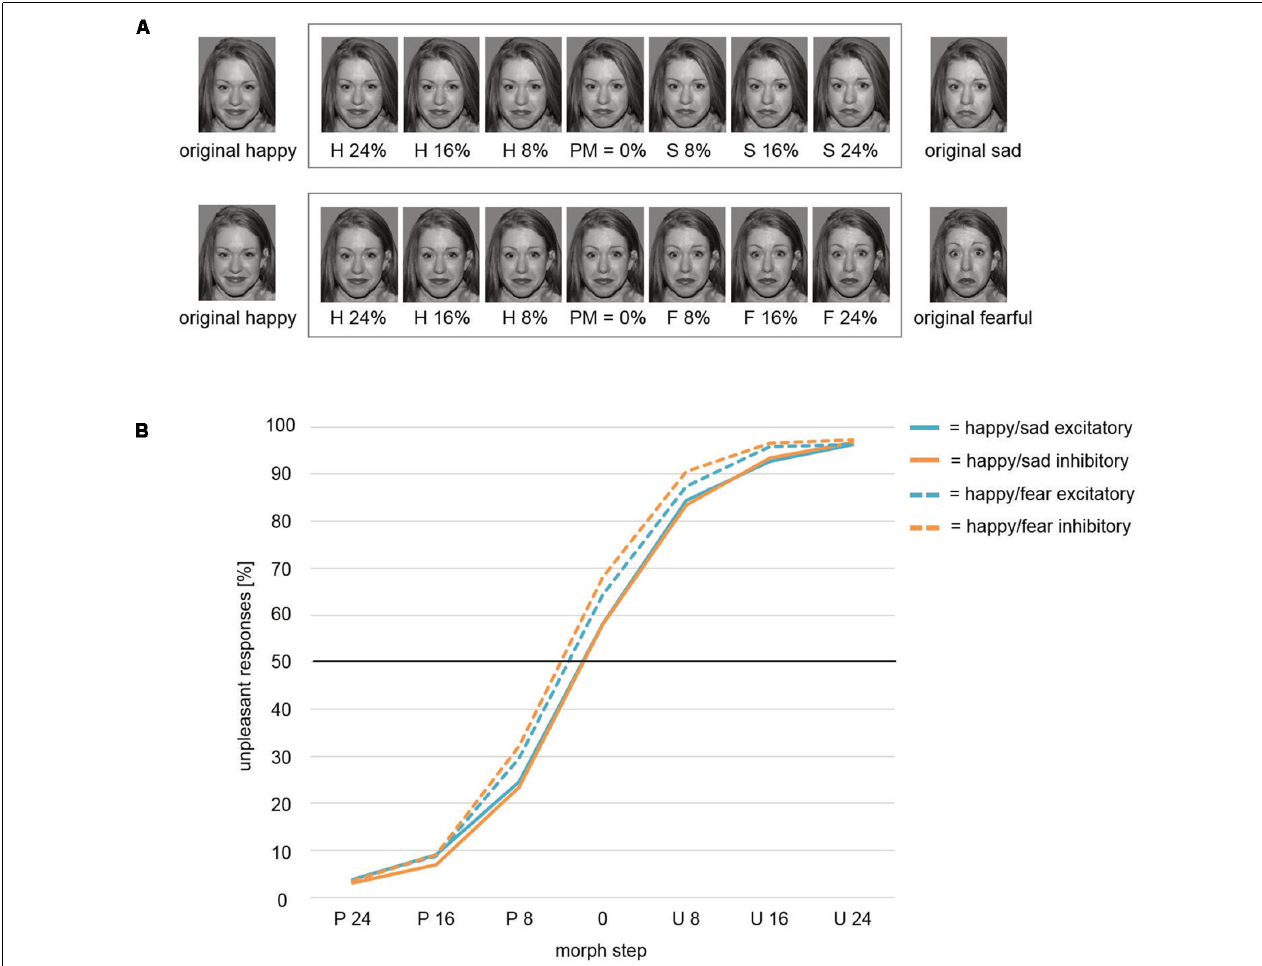
FIGURE 2 | (A) Face-morph task. Morphed facial stimuli from left to right show increasing sad (top row)/fearful (bottom row) and decreasing happy facial expressions. The pre-assessed perceptual midpoint (PM) is centrally positioned. Six morph steps around PM were chosen for optimal response function coverage. Letters indicate the relatively dominant emotion (H, happy; S, sad; F, fearful). Numbers within the frame indicate the added percentages toward the respective emotion (e.g., H 16% = PM + 16% increase in happy expression/16% decrease in sad/fearful expression). Stimuli outside the frame were used for creating face morphs and were not featured in the respective final tasks. To avoid morphing artifacts, stimuli were prepared by means of Photoshop software (Adobe Systems) beforehand. Therefore, the here exemplarily displayed happy faces differed slightly across studies. However, retouching only focused on the hair area. No changes were applied to the facial area. The identifiable image is model #1 from the NimStim Set of Facial Expressions (Tottenham et al., 2009) and is released for publication in scientific journals. (B) Weibull fitted response function. The Weibull function modeled mPM and the shape parameter β did not differentiate between stimulation conditions Inhibitory and Excitatory for the presentation of ambiguous happy-sad face morphs. However, a significant main effect for factor Study revealed an overall shift of the mPM for happy-sad faces toward happier faces relative to happy-fearful faces. Thus, participants in study Happy/Sad needed higher amounts of unpleasant, i.e., sad facial expressions to categorize an ambiguous face morph as unpleasant/sad in comparison to participants in study Happy/Fear. P, Pleasant; U, Unpleasant.